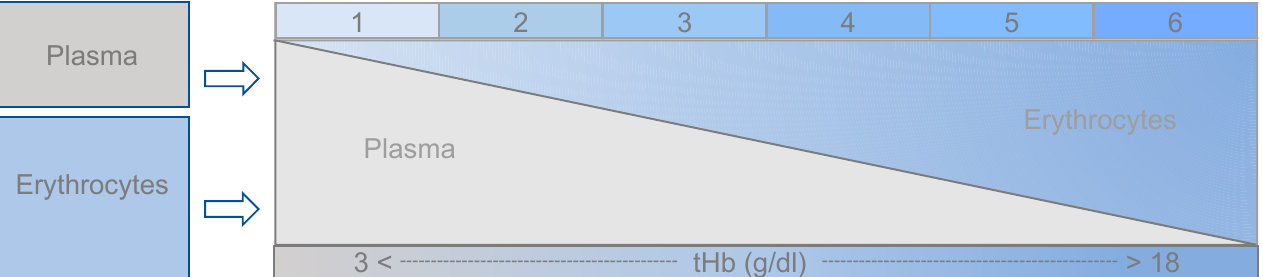
Figure 1. Configuration of the 6 basic blood units (approx. 20 mL, fast check with HemoCue), then separated in: 8 BGA cuvettes with 2 mL (Sarstedt, ∑ 16 mL); 2 blood count cuvettes with 1 mL (Sarstedt, ∑ 2 mL), 2 cuvettes with 1 mL ( ∑ 2 mL) for AHD processes, ABL 80, and OSM 3 HemoCue = 9 × microcuvettes.